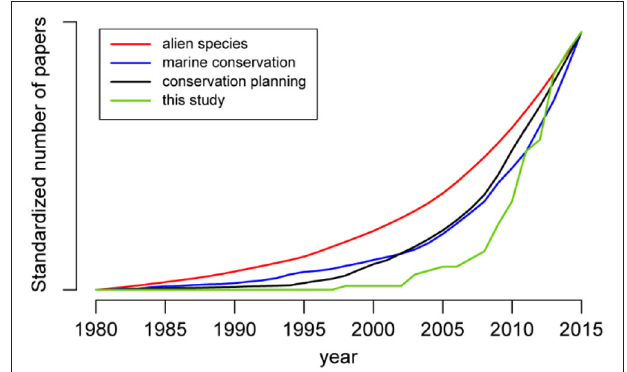
FIGURE 1 | Cumulative number of scientific papers reviewed in this study compared with the results appearing in Scopus by only using the keywords “non-native species,” “marine conservation,” or “conservation planning” (all standardized between 0 and 1). Source: Scopus (October 2016).